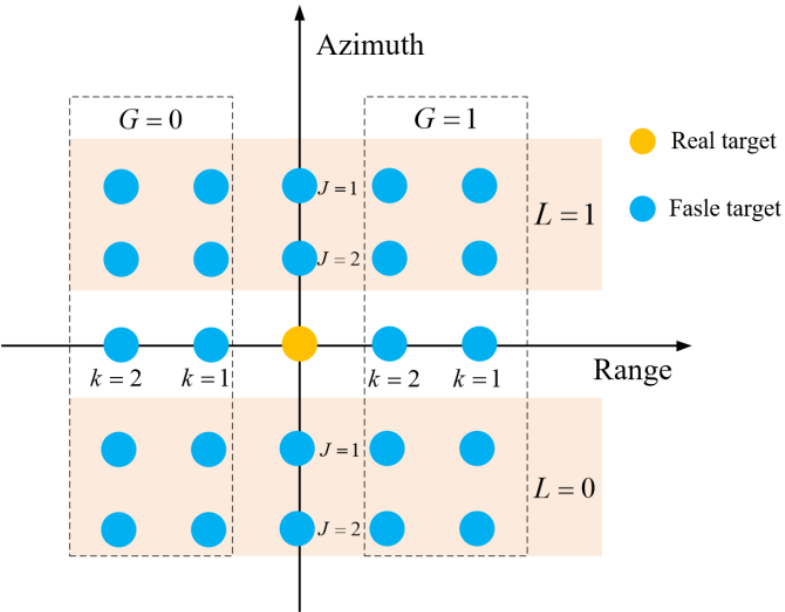
Figure 8. Derivation schematic diagram of false target position distribution (taking M a = M r = 3 as an